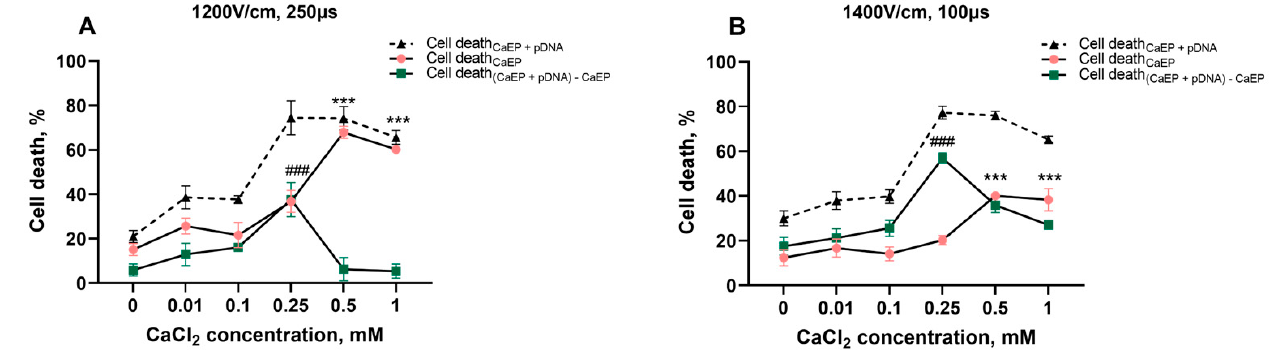
Figure 4. The dependence of cell death on the applied electric field at different CaCl 2 concentrations. Cells were treated using one square pulse of 1200 V/cm for 250 μ s ( A ) or 1400 V/cm for 100 μ s ( B ). Results were evaluated 24 h after electroporation. Error bars represent the standard error of the mean (SEM) of n = 9 experimental replicates. In case standard errors were lower than actual data points, error bars are not visible. The statistical significance between the control (0 mM) and the 0.1, 0.01, 0.25, 0.5, and 1 mM CaCl 2 concentrations is denoted by *** (cell death induced by calcium elec- troporation) and ### (cell death induced by pDNA). *** and ### represents the p < 0.001.